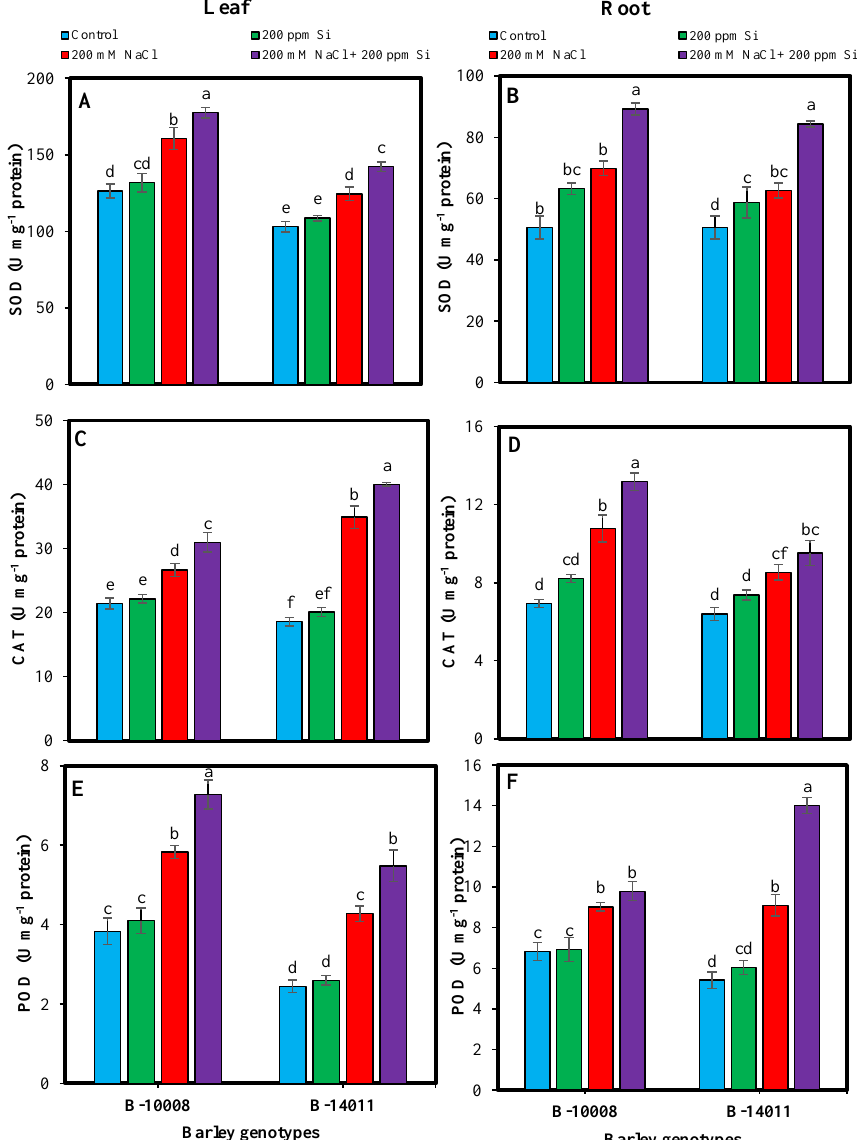
Figure 1. Superoxide dismutase (SOD) ( A , B ), catalase (CAT) ( C , D ) and peroxidase (POD) ( E , F ) (U mg −1 protein) contents in leaf and root of barley genotypes modulated by application of silicon through rooting media under salinity stress. The values represented by bars are means of four replicates ± SE. Different small letters (a–f) on bars denote significant difference at p ≤ 0.05 (Duncan’s multiple range test). Values sharing same letter within each subfigure are non-significant statistically.